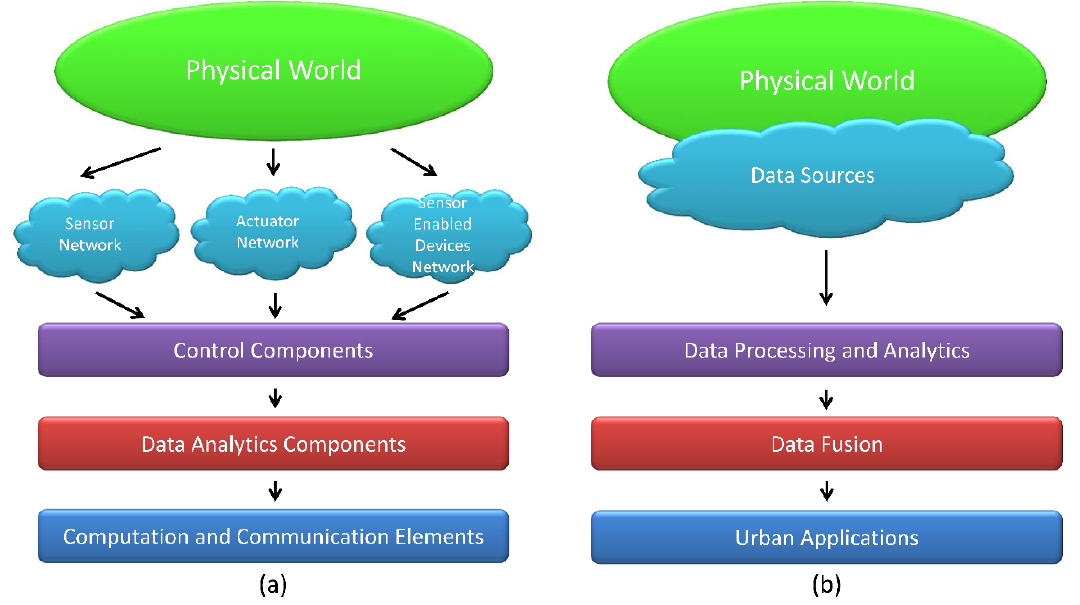
Figure 3. From Cyber–Physical Systems (CPS) to a data-driven CPSS; ( a ) main elements of a CPS framework and ( b ) data-oriented CPSS functional elements.